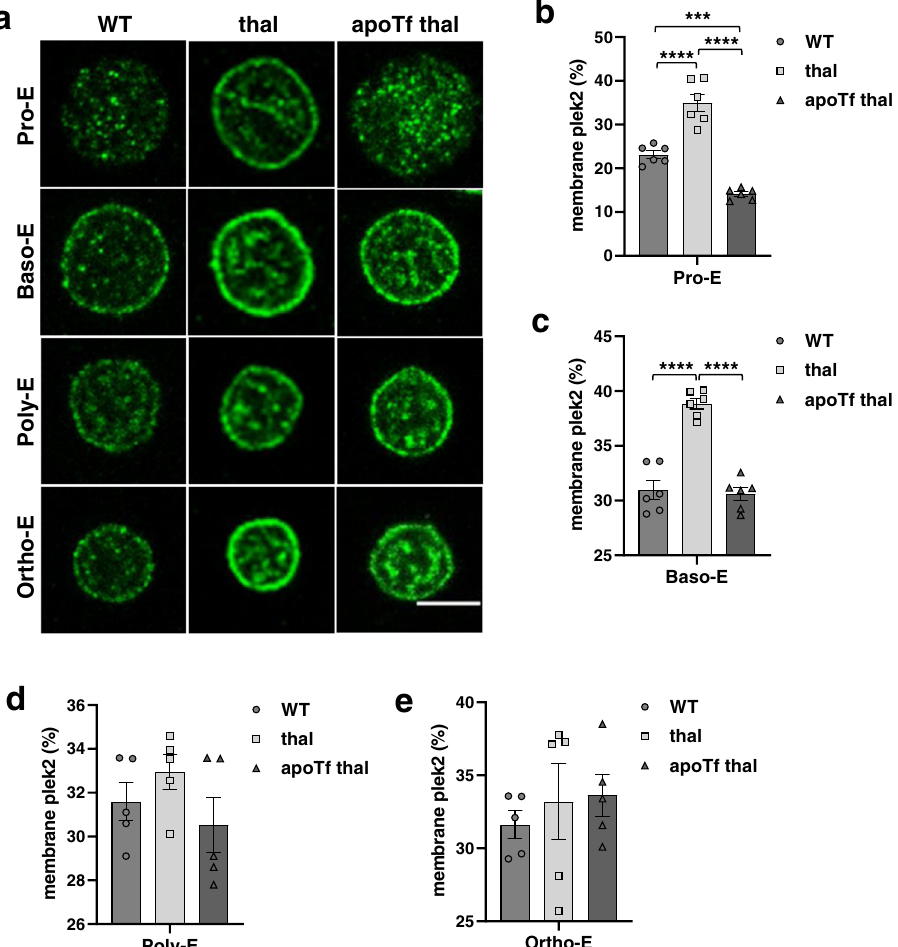
Fig. 4 Early pleckstrin-2 activation and membrane localization during β -thalassemic erythroid precursor differentiation. a Confocal immuno fl uorescence microscopy of plek2 (green) localization in sorted (2 – 3 mice pooled per data point, n = 3 data points per category) WT, β - thalassemic, and apoTf-treated β -thalassemic erythroblasts demonstrate an increased percentage of membrane plek2 localization relative to total plek2 in β -thalassemic relative to: b WT Pro-E and c Baso-E from mice, normalized in apoTf-treated β -thalassemic Pro-E ( b ) and Baso-E ( c ) with no differences in: d Poly-E and e Ortho-E. The confocal images were representative optical sections of the cell from at least 50 cells in each condition in 2 different experiments. Scale bar 5 µ m. All data are reported as mean ± s.e.m. and p < 0.05 was considered statistically signi fi cant (one-way ANOVA) (* p ≤ 0.05, ** p ≤ 0.005, *** p ≤ 0.0005). WT = wild type; apoTf = apo-transferrin; plek2 = pleckstrin-2; Pro-E = pro-erythroblasts; Baso-E = basophilic erythroblasts; Poly-E = polychromatophilic erythroblasts; Ortho-E = orthochromatophilic